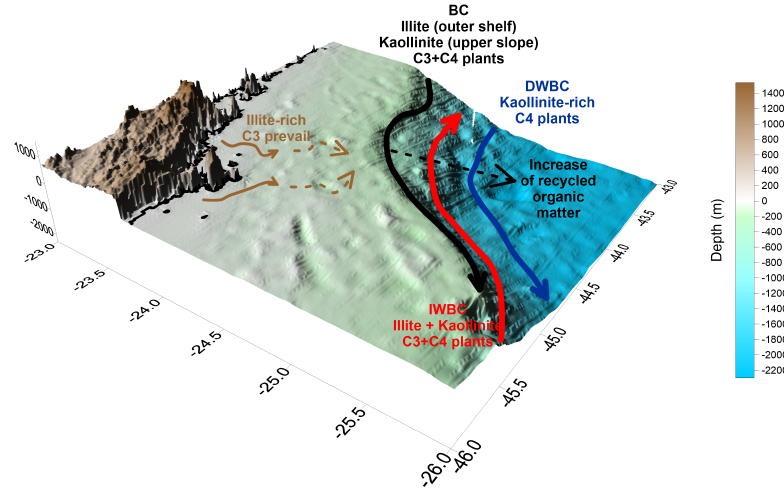
Figure 7. Conceptual model for the source and transport of inorganic and organic material in the study